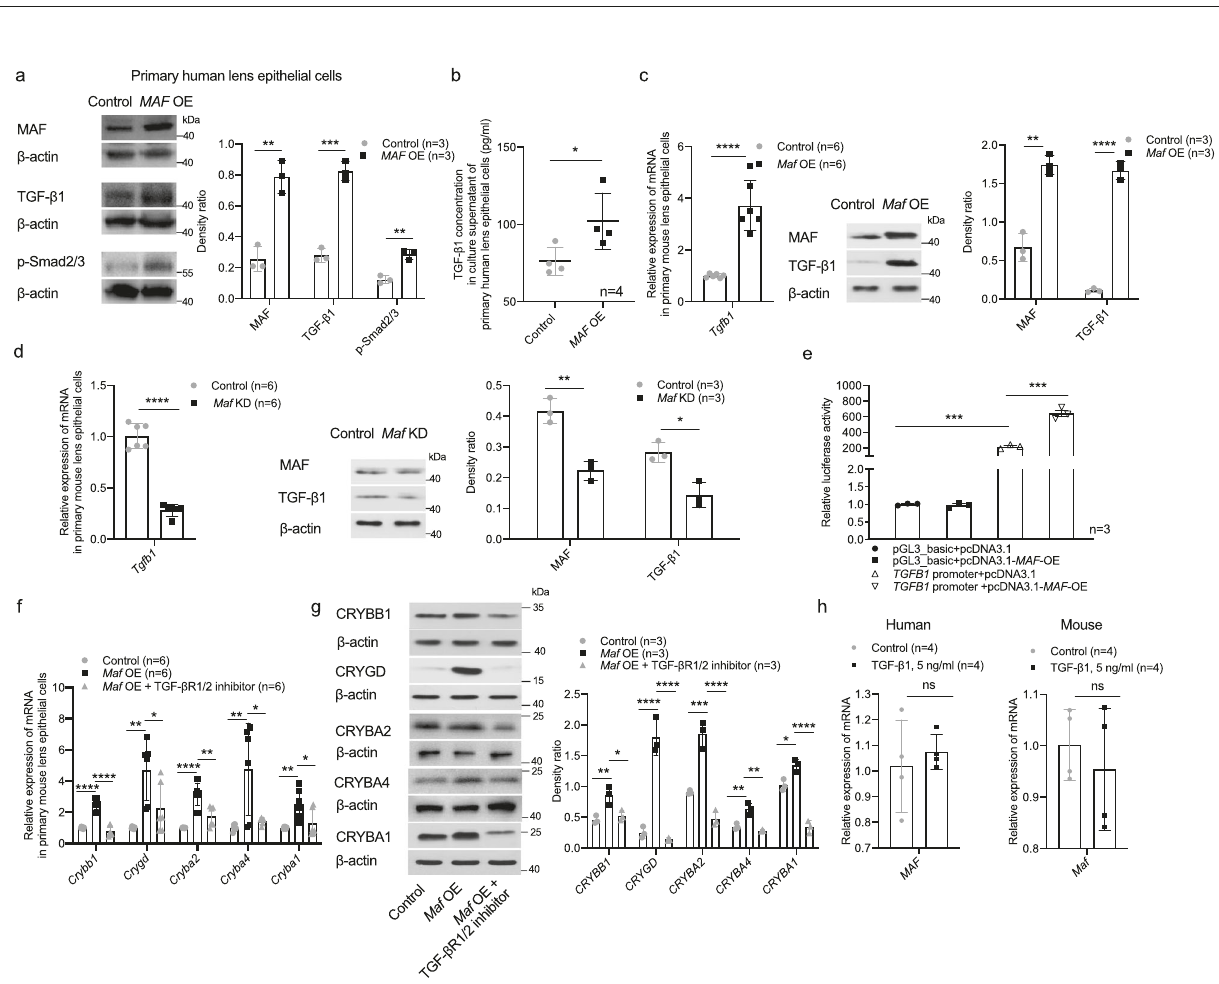
Fig. 8 Promoted proliferation of lens epithelial cells by TGF- β 1. a EdU incorporation assay of primary human LECs from emmetropic and highly myopic eyes ( n = 6, p = 0.0006). Scale bar: 100 μ m. b Primary culture of human LECs showing the migration of LECs from the rim of epithelium ( n = 3, p = 0.041). Scale bar: 500 μ m. Black arrows show the original lens epithelium rim and the yellow dashed lines refer to the place where proliferating LECs outreached. c EdU incorporation assay of primary human LECs from emmetropic eyes after TGF- β 1 treatment (5 ng/ml for 24 h, n = 5, p = 0.013). Scale bar: 100 μ m. d Primary culture of human LECs from emmetropic eyes showing the migration of LECs from the edge of epithelium after TGF- β 1 treatment (5 ng/ml for 24 h, n = 3, p = 0.002). Scale bar: 500 μ m. Black arrows show the original lens epithelium rim and the yellow dashed lines refer to the place where proliferating LECs outreached. e CCK-8 cell viability assay of primary human LECs with and without TGF- β 1 treatment (5 ng/ml for 24 h, n = 4, p = 0.030). f Ki67 staining of primary human LECs with and without TGF- β 1 treatment (5 ng/ml for 24 h, n = 5, p = 0.0004). Scale bar: 100 μ m. n = biological replicates. Results are expressed as mean ± SD. Level of signi fi cance was detected by two-sided Student ’ s t test ( a , c , e , and f ) and repeated measures ANOVA ( b and d ), multiple comparison was not conducted). *** p < 0.001 and * p < 0.05. Source data are provided as a Source Data fi le.